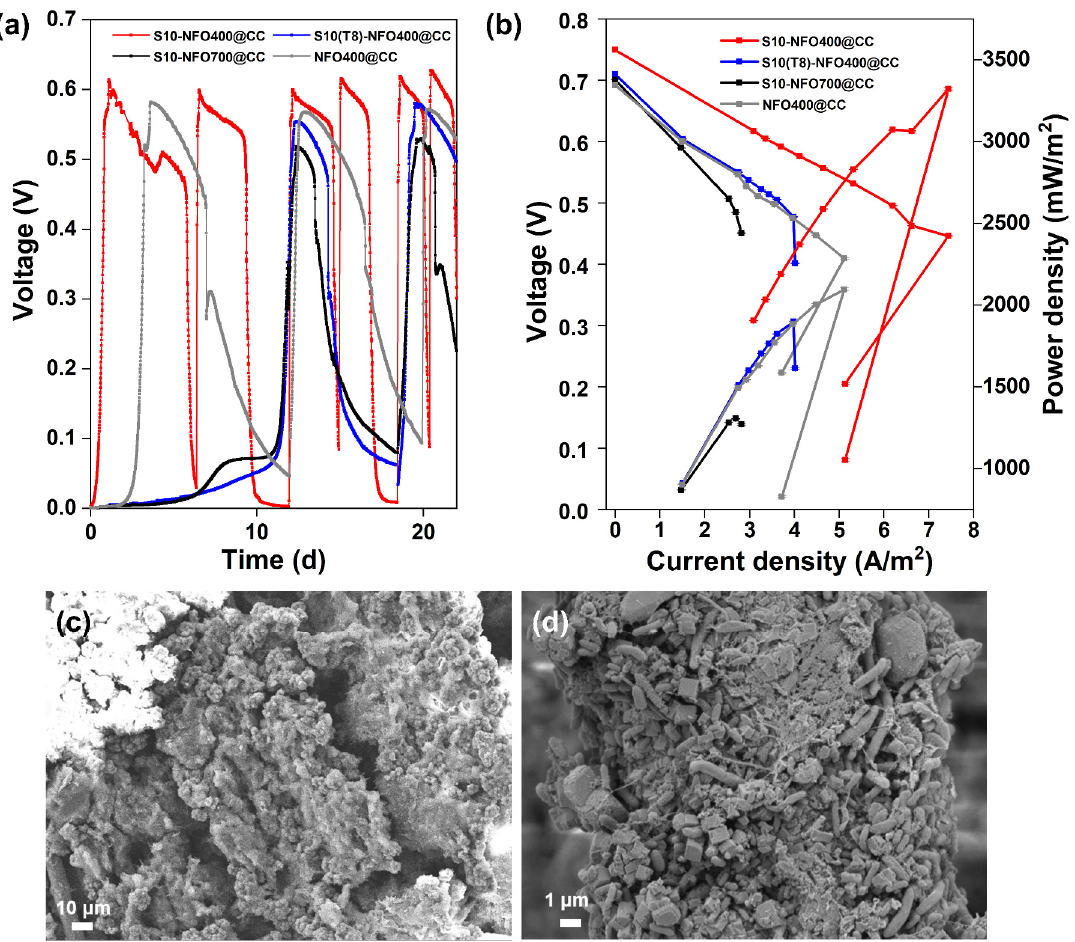
Figure 3. S10-NFO@CC as MFC anodes. ( a ) Start-up voltages, ( b ) Polarization and power density curves of S10-NFO400@CC (red curve), S10(T8)-NFO400@CC (blue curve), S10-NFO700@CC (black curve). SEM images of biofilm growth on ( c ) S10-NFO400@CC anode, and ( d ) S10(T8)-NFO400@CC anode.